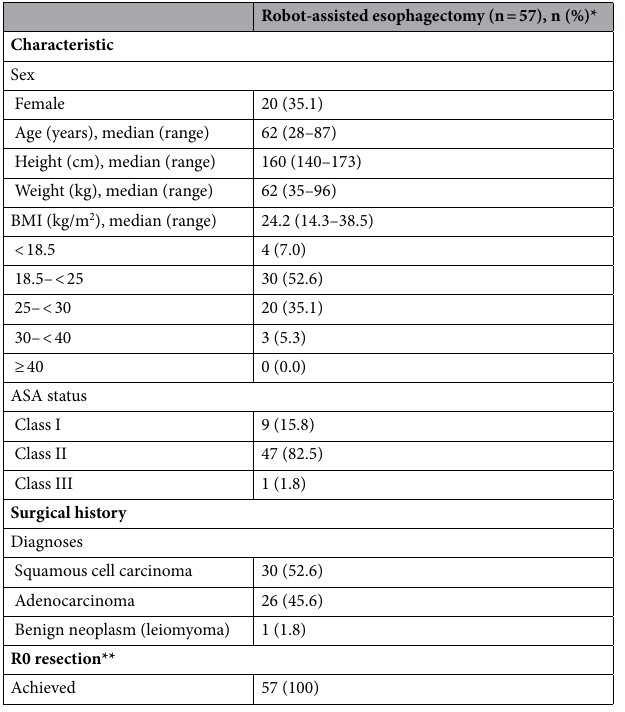
Table 1. Patient characteristics, surgical history and R0 resection rate. *Data are expressed as n (%) unless specified otherwise. **R0 resection is defined as the absence of residual tumor at 1 mm of the residual margin 14 . ASA American Society of Anesthesiologists 28 , BMI body mass index.